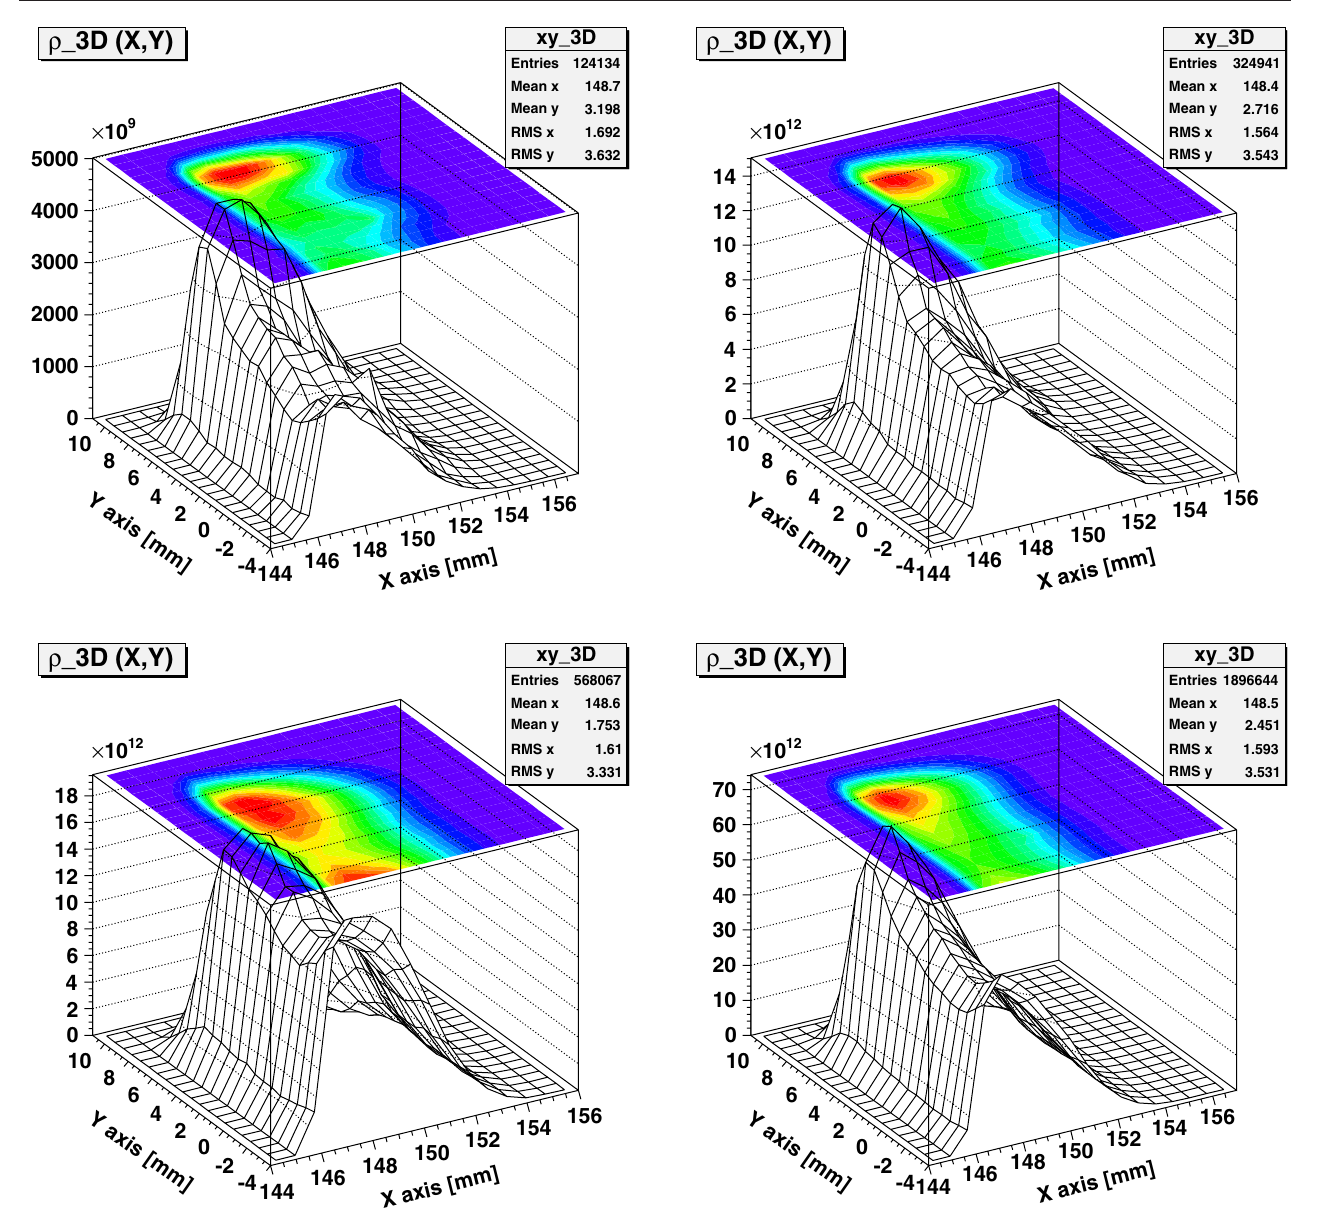
FIG. 6. Hit distributions in the foil at the 1st (top, left), 6th (top, right), 4th (bottom, left), and during all the six (bottom, right) cycles of the 582-turn injection. In the simulations, the particle hit number on the foil during the 1st, 4th, and 6th cycles is 62 067, 162 470, and 284 034, respectively. The total hit number during the injection is 948 322. Average number of interactions with the foil for each injected particle is 33. Hit density at the maximum of the distribution is 1 : 31 (cid:3) 10 14 proton = mm 2 at 2 : 52 (cid:3) 10 11 particles injected at every